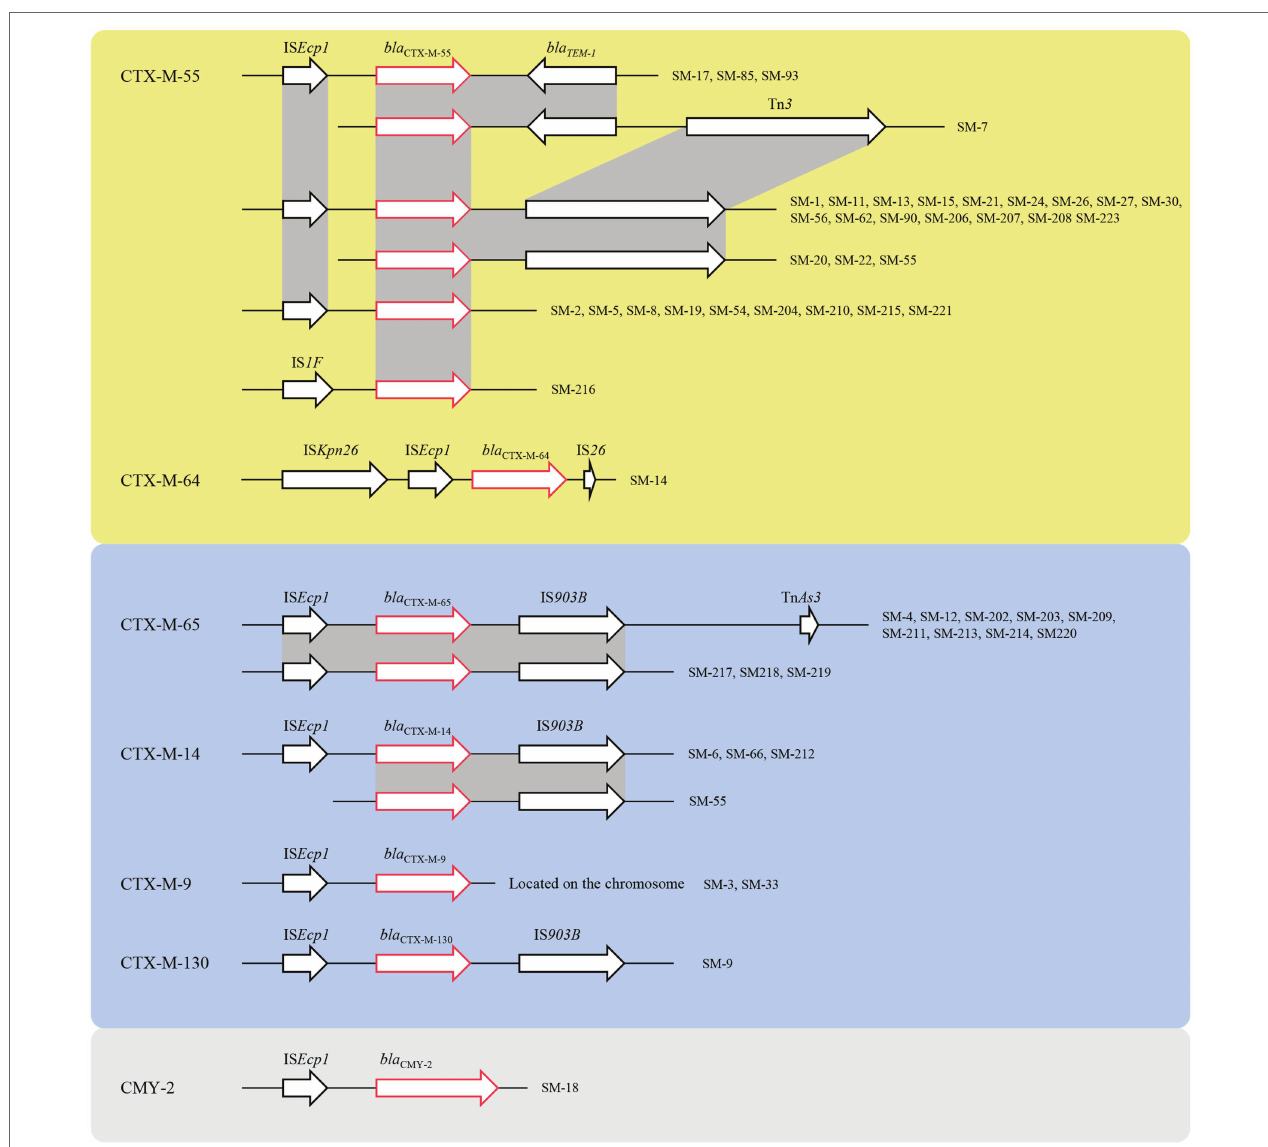
FIGURE 2 | The genetic environment of ESBL, the yellow region represented for CTX-M-1 group, the blue region represented for the CTX-M-9 group, and the grey region represented CMY-2. The red arrows represented for the resistance genes, and the black arrows represented for the mobile genetic elements